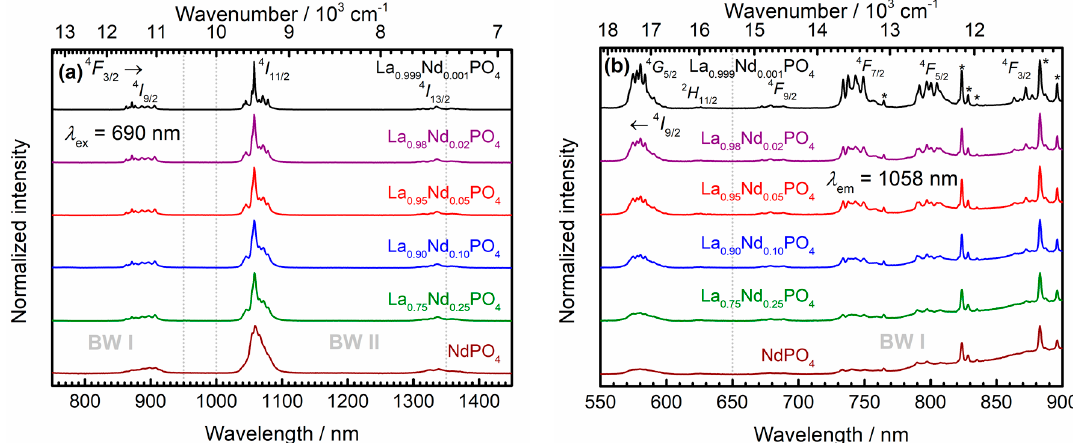
Figure 4. ( a ) Photoluminescence spectra of the powdered La 1- x Nd x PO 4 nanocrystals acquired upon laser excitation with 690 nm at room temperature. The respective transitions and biological